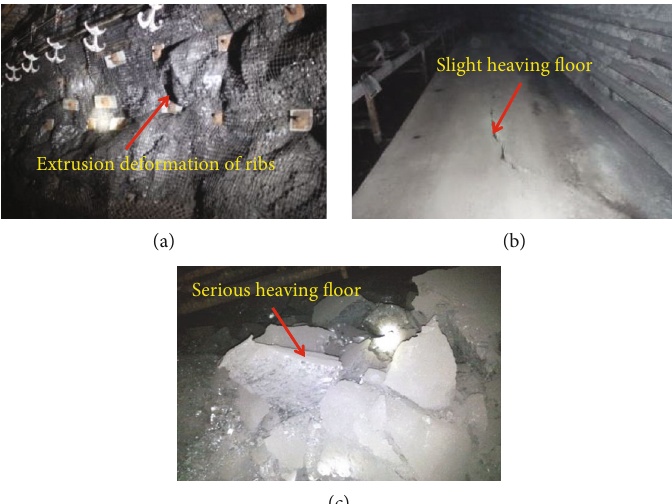
Figure 6: The typical surrounding rock failure forms of roadways on site. (a) Extrusion deformation of ribs. (b) Slight heaving fl oor. (c) Serious heaving fl oor.